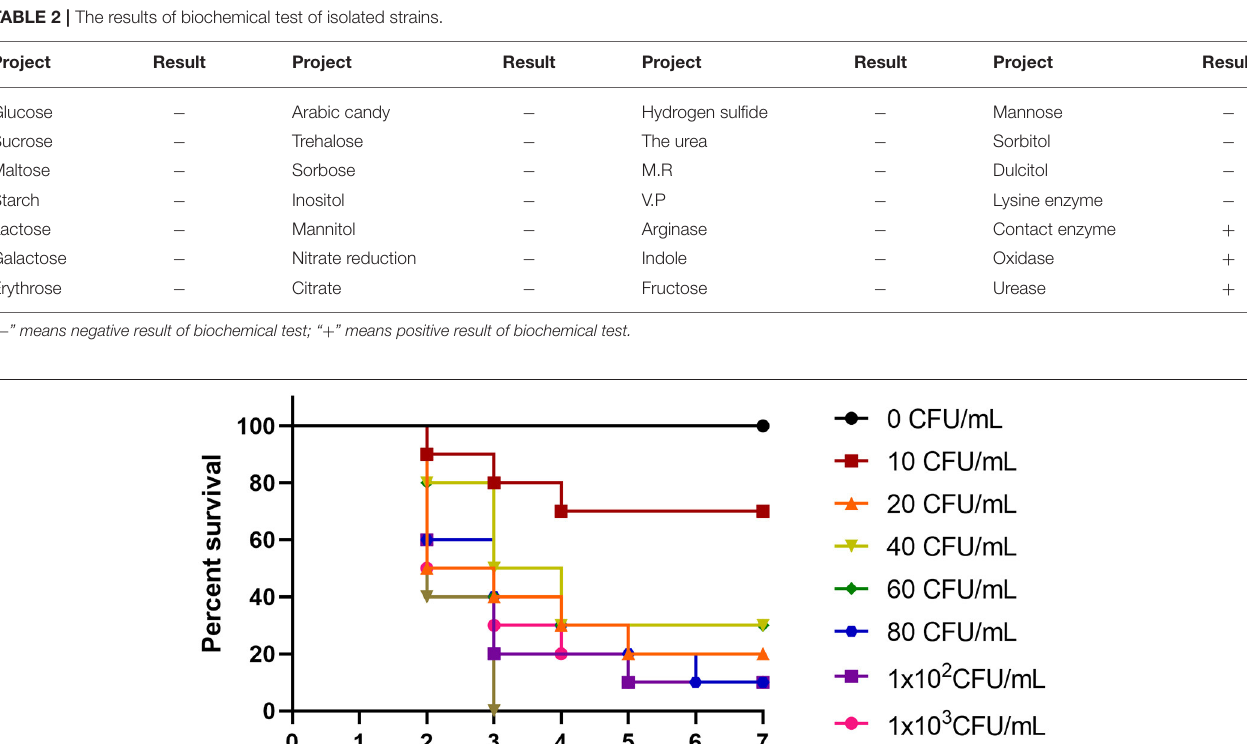
or residual necrotic fragmented nuclei. The necrotic focus was a large area of eosinophilic homogeneous fibrinoid